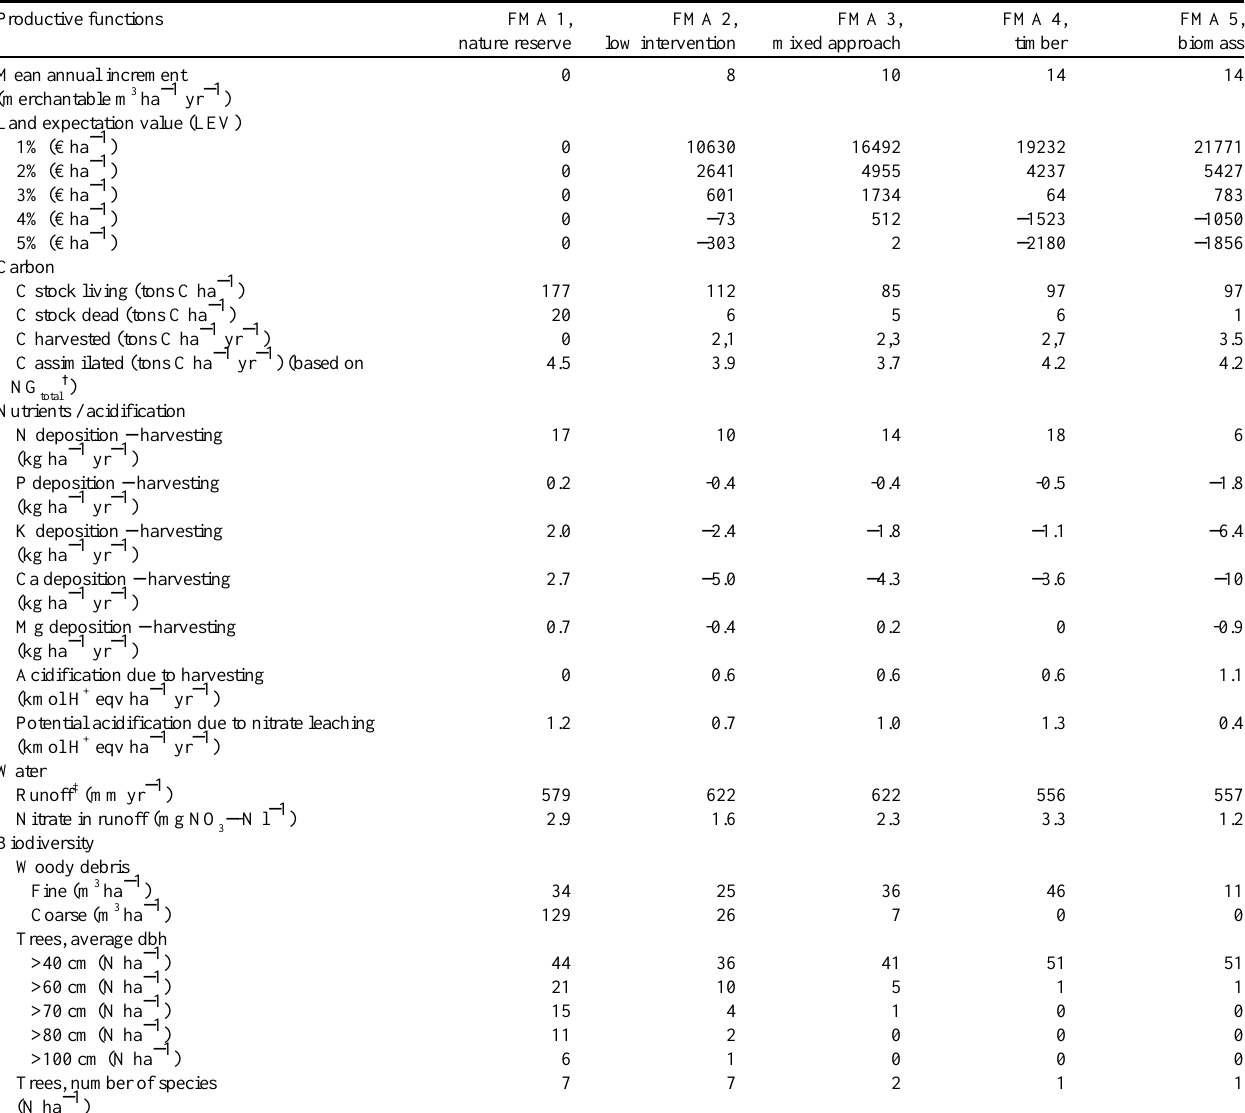
Table 3 . Effects of the forest management alternatives (FMAs) on multiple forest ecosystem services. Productive